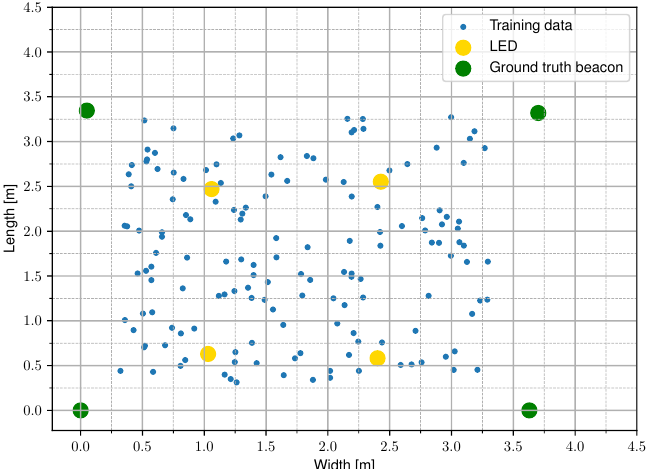
Figure 4. A conceptual top view of the setup with four LEDs at a height h . The measured data from the experimental set-up is sampled randomly in the receiver